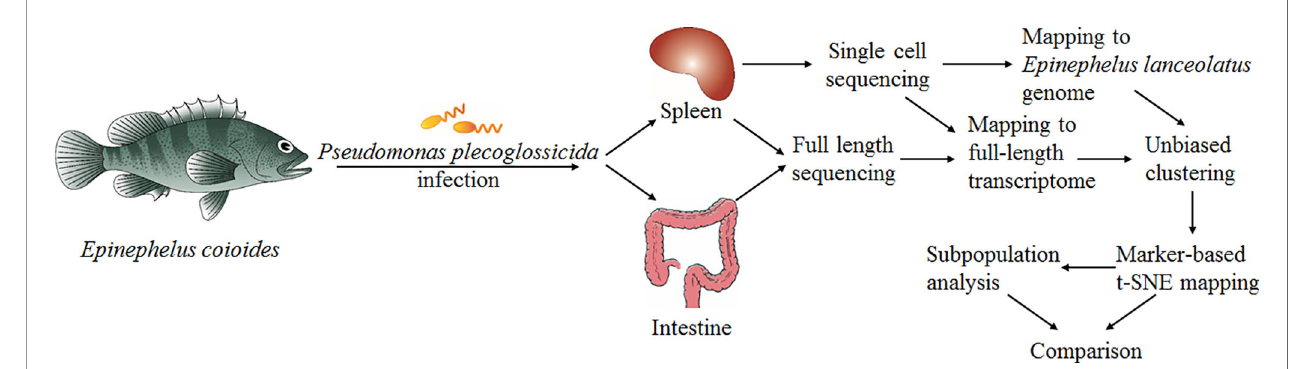
FIGURE 1 | Overall work fl ow diagram of cell classi fi cation and single cell sequencing analysis.